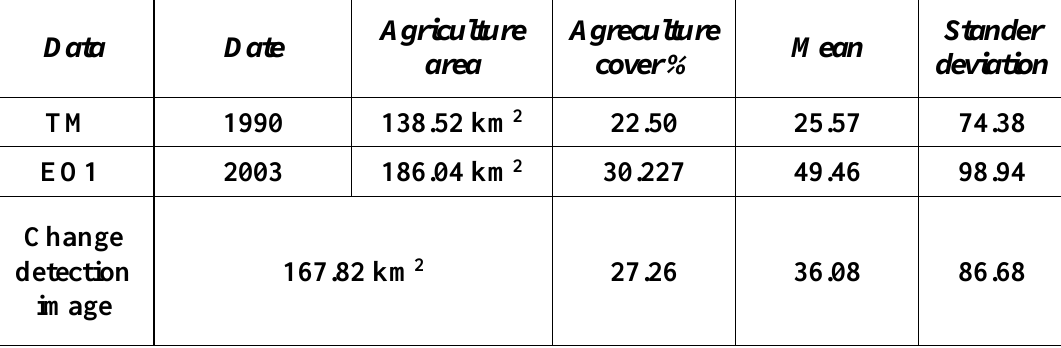
Table 2: Characteristics of STVI-4 vegetation indices for both TM & ALI Satellite images.